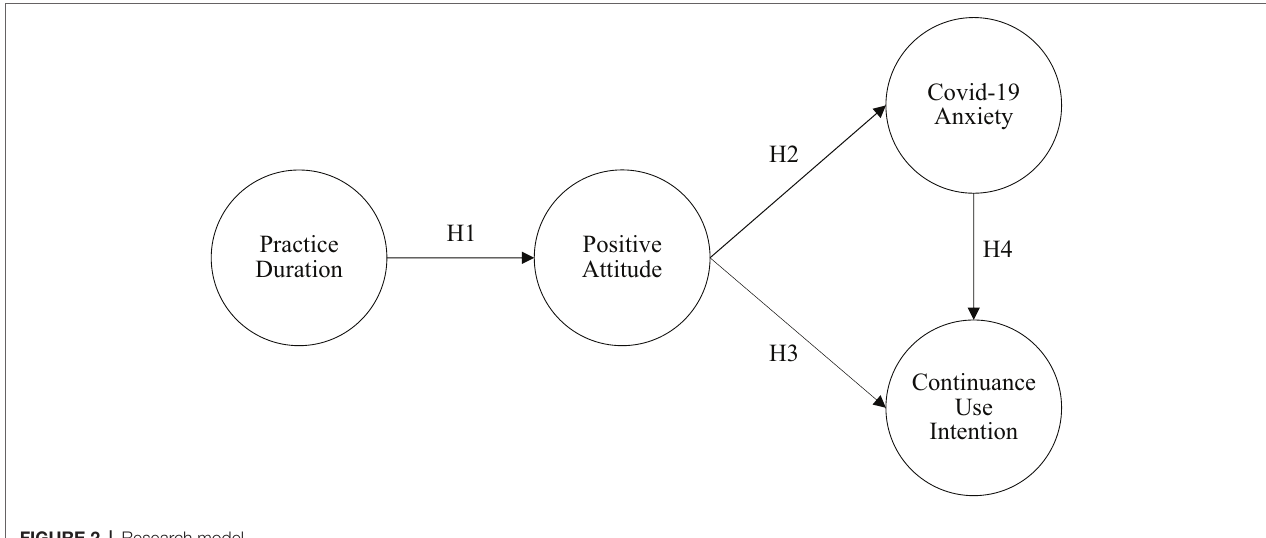
FIGURE 2 | Research